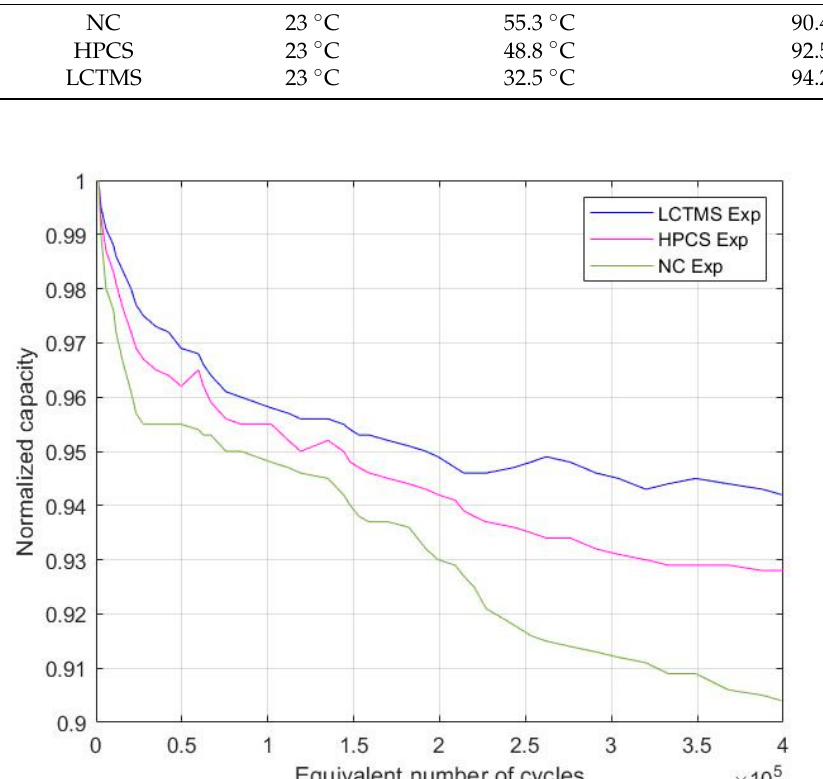
Figure 6. The LiC capacity fade in three case studies: without any TMS under NC, with HPCS, and with LCTMS.